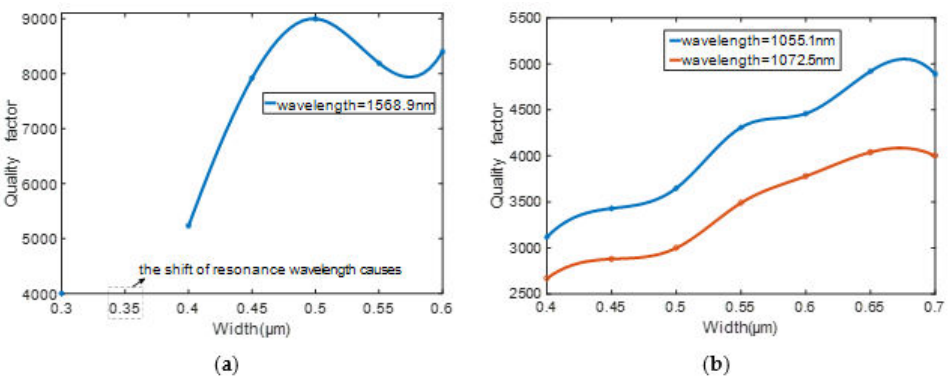
Figure 9. Relationship between the Q value and waveguide width. ( a ) silicon. ( b ) silicon nitride.